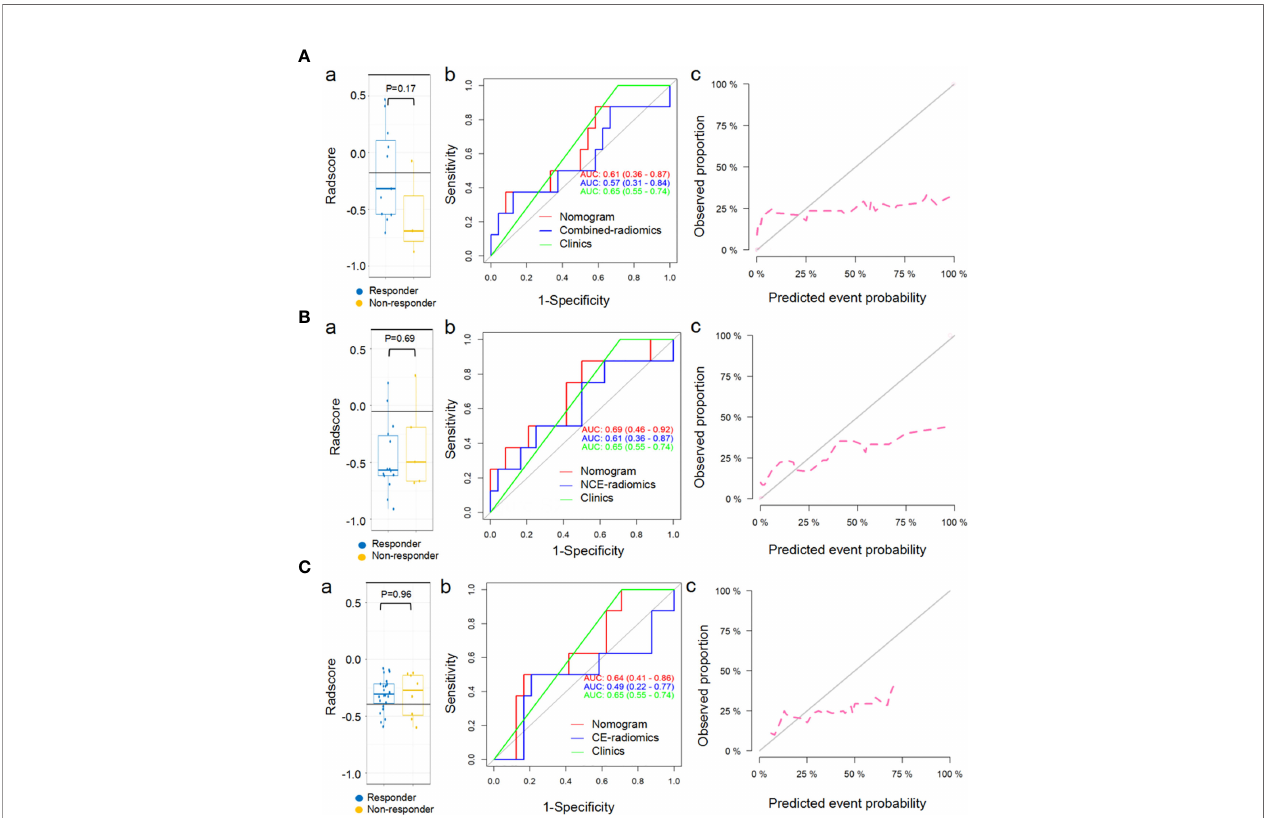
FIGURE 6 | Predictive performance of combined-radiomic (A) , NCE-radiomic (B) and CE-radiomic (C) models in chemotherapy cohorts. (Aa, Ba, Ca) Box and whisker plots depict radscore comparison between responders and non-responders. (Ab, Bb, Cb) ROC curves of radiomics signatures in chemotherapy cohorts. (Ac, Bc, Cc) Calibration curve analysis for the nomograms in chemotherapy